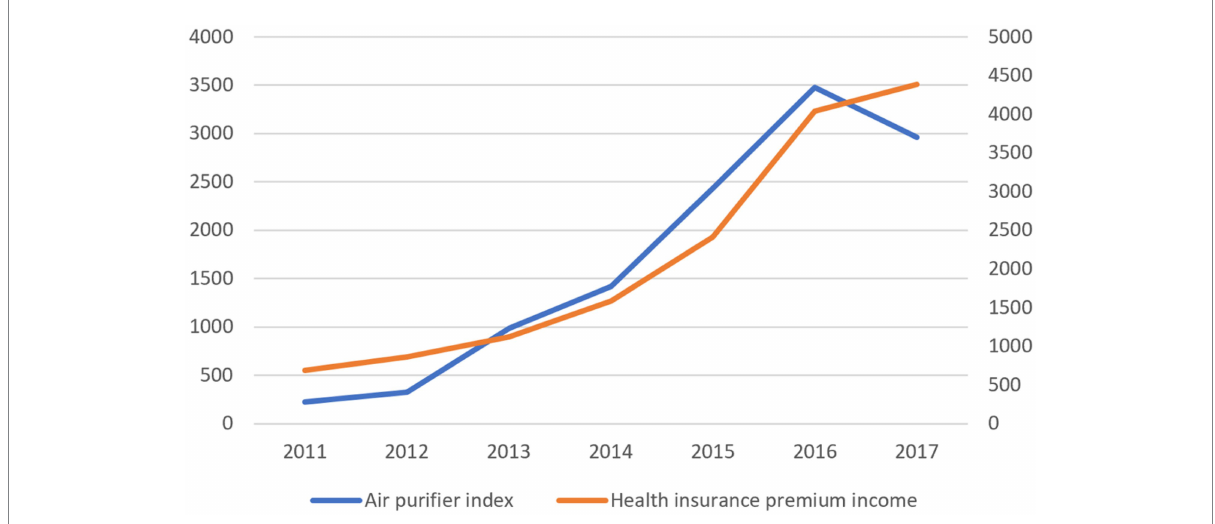
FIGURE 1 Relationship between health risk cognition and coping behavior. The left vertical axis of the figure is the premium income of commercial health insurance, and the right vertical axis is the moving daily average of the Baidu Index of air purifiers. The premium income data comes from the premium income data of insurance companies on the National Bureau of statistics